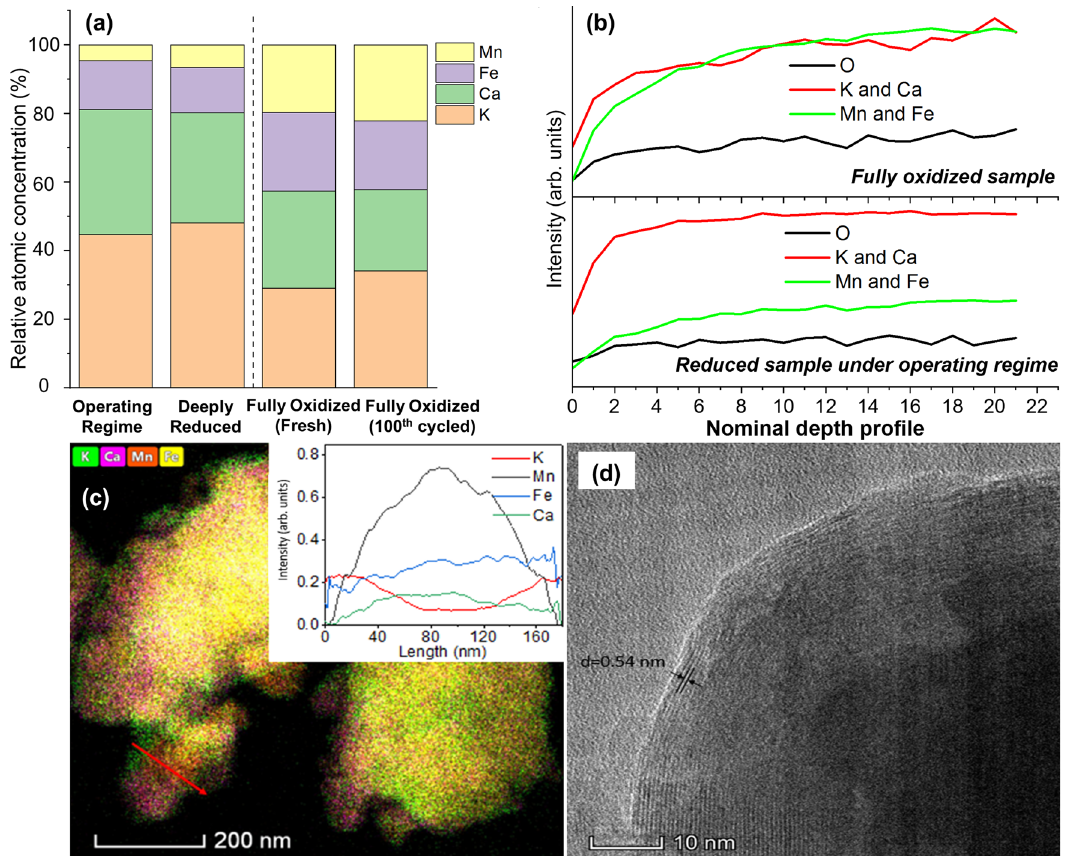
Fig. 4 Surface and morphology characterizations of the redox catalyst. a XPS surface elemental composition, b low-energy ion scattering (LEIS) depth pro fi ling, c EDS and line scan, and d high-resolution TEM of surface